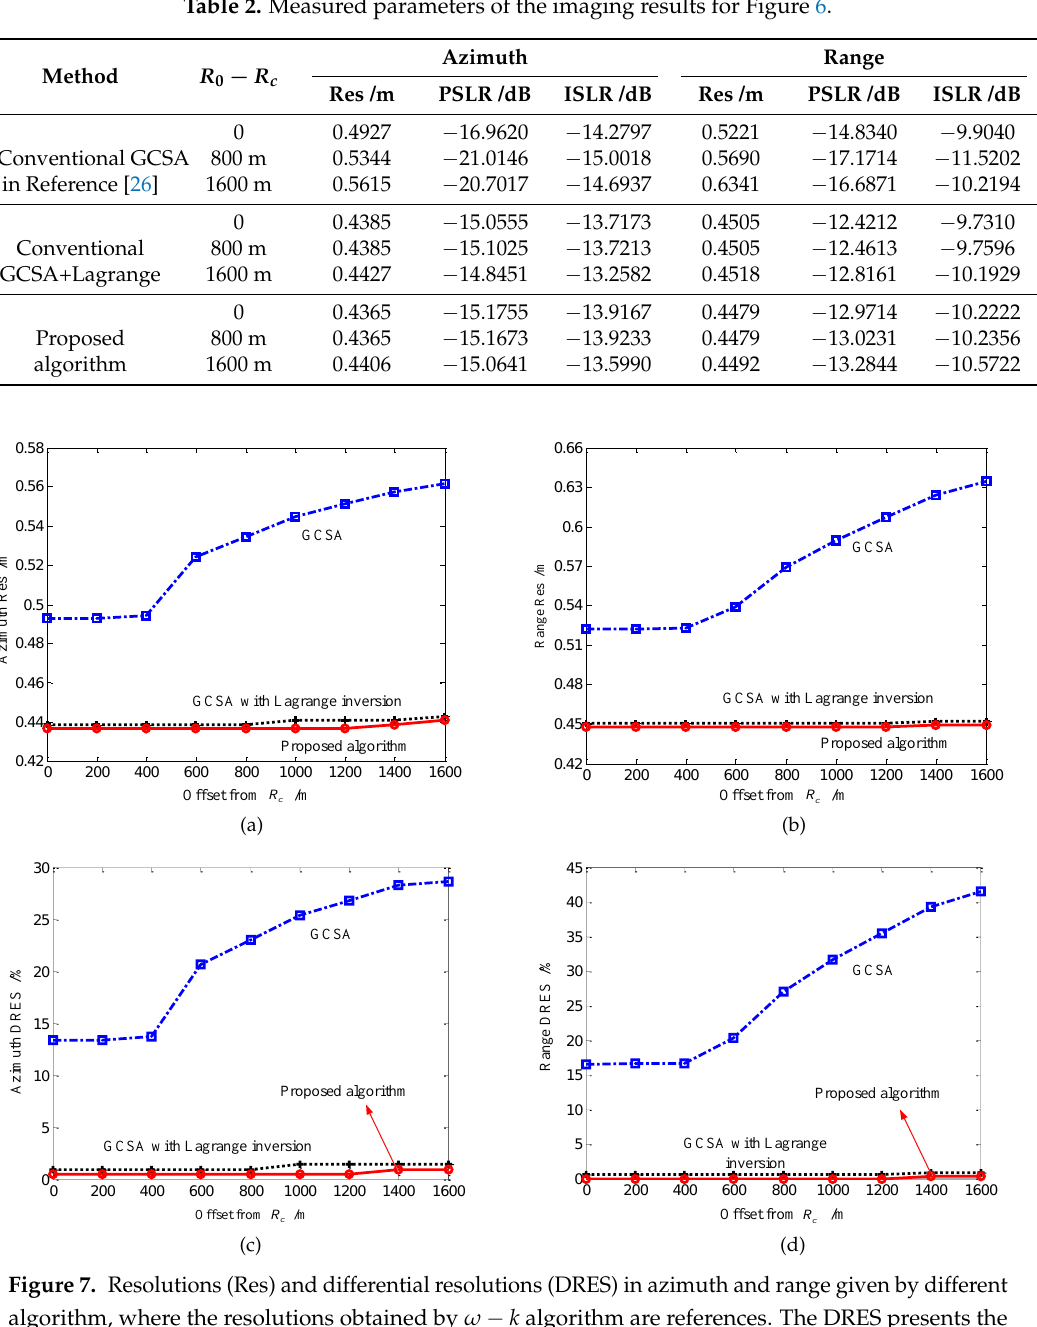
Table 2. Measured parameters of the imaging results for Figure 6.